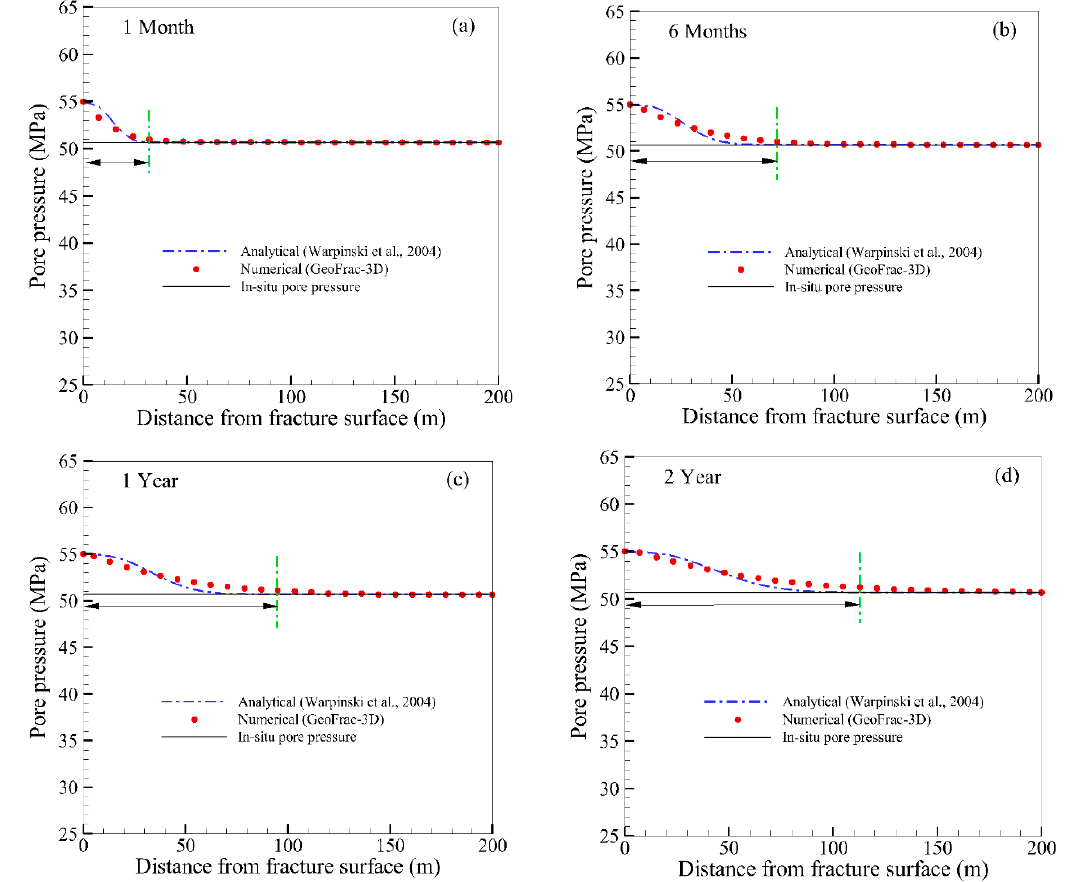
Figure 5. Comparison of reservoir pore pressure distribution from the GeoFrac-3D model and analytical solution [58] along a line perpendicular to a pressurized 3D flat elliptical fracture; ( a ) time = 1 month, ( b ) time = 6 months, ( c ) time = 1 year, ( d ) time = 2 years of pressurization time (fracture half-length = 90 (m), fracture height = 60 (m), fluid pressure = 55.0 (MPa), in situ reservoir pore pressure = 50.68 (m) at the wellbore level). The pore pressure diffuses further into the formation over time (i.e., shown by “doubled sided arrow” mark). Table 1. Physical properties of the reservoir rocks in different layers.